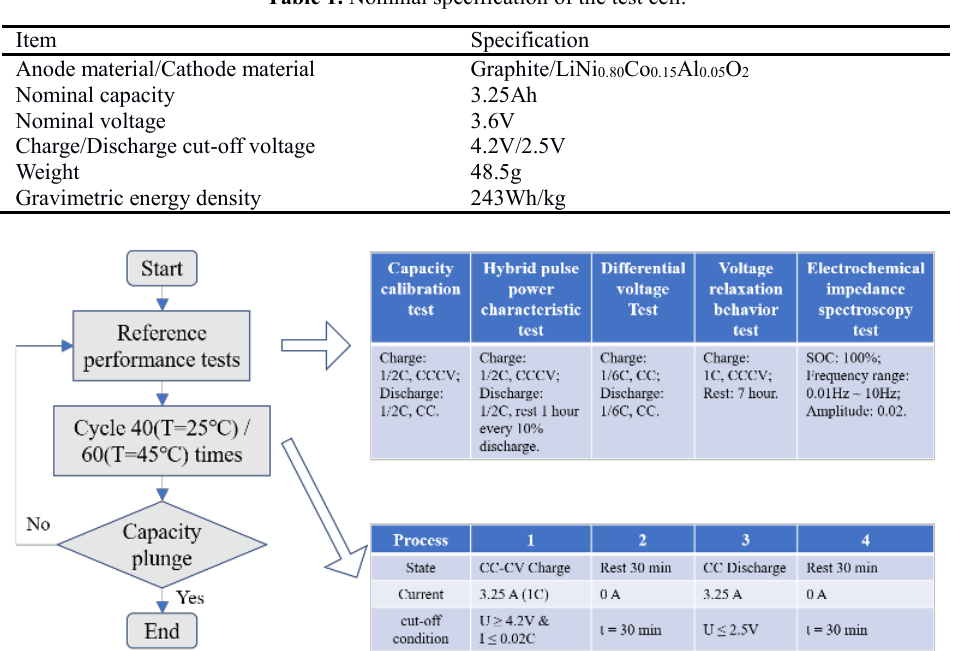
Table 1. Nominal specification of the test cell.